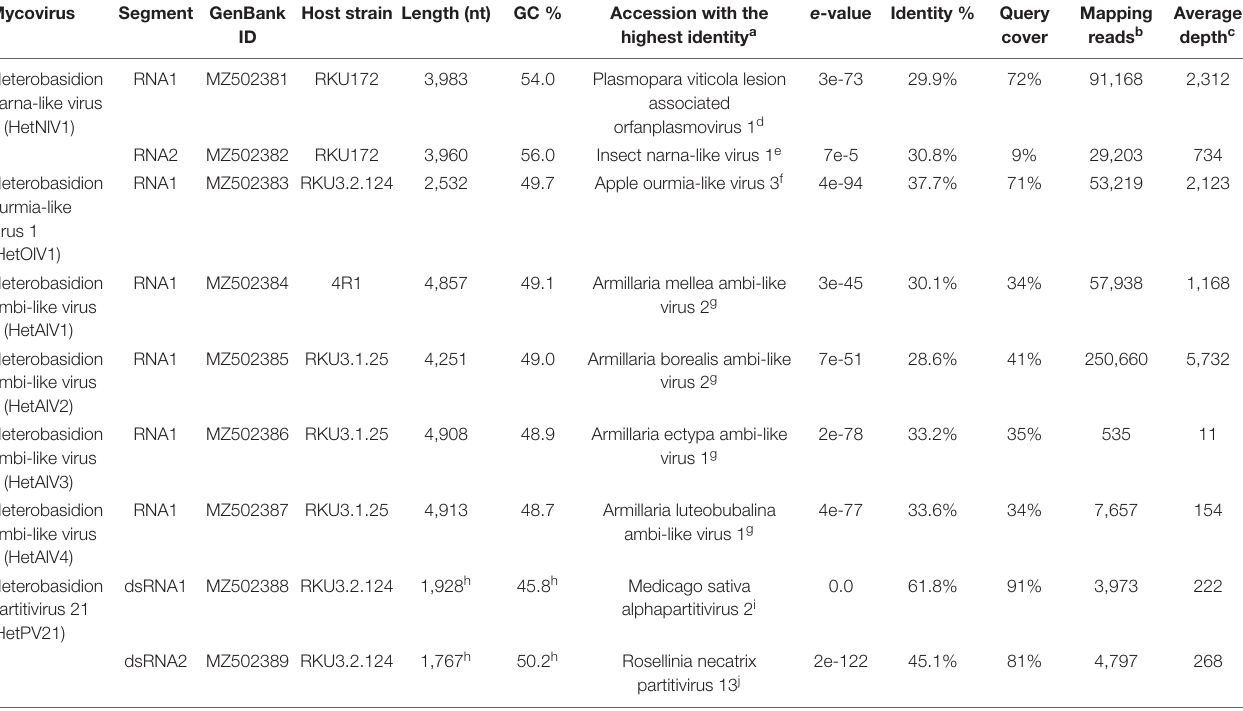
TABLE 1 | Novel mycoviruses detected in our H. parviporum isolate collection. Mycovirus